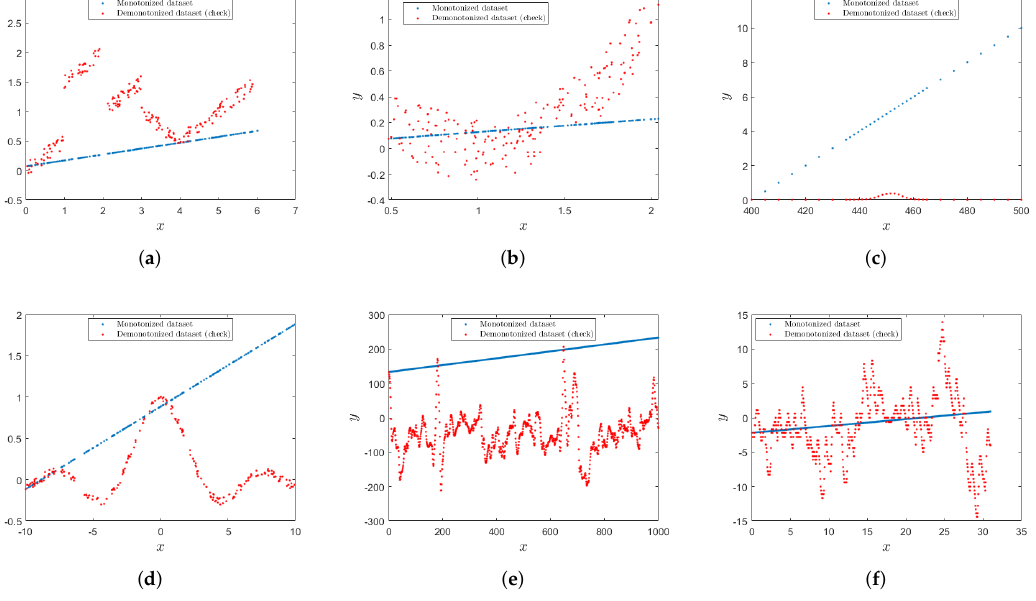
Figure 2. Results of monotonization/demonotonization applied to: ( a ) Data set 1, ( b ) Data set 2, ( c ) Data set 3, ( d ) Data set 4, ( e ) Data set 5, ( f ) Data set